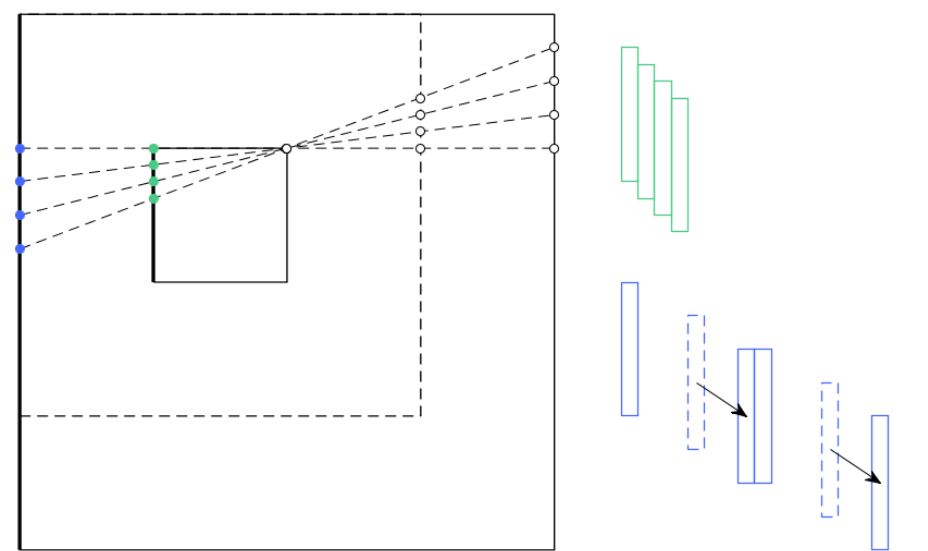
Figure 3. Depiction of how initial DRT values map to a 4 times bigger DRT. A few dashed lines on the left are represented on Radon slope-displacement space on the right. On green, initially contiguous values in slope with incrementally decreasing displacement, map to slopes at distance four and with double displacement increments, on a 4 times bigger DRT, on blue. Moreover, the blue originally odd slopes get an additional increase of 3 in slope, and 2 in displacement that will be discussed